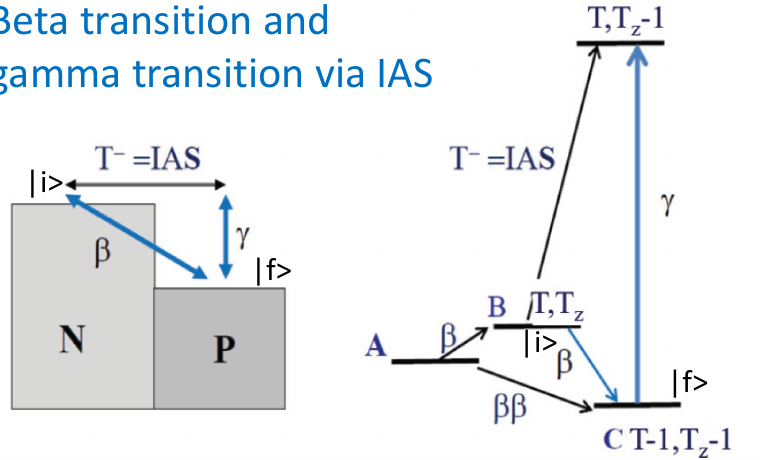
Figure 11. Schematic diagram of β decay from |i> to |f> and γ transition from |f> to the isobaric analog state (IAS) state |IAS> = T − |i> with T − being the isospin lowering operator. They are analogous with each other.